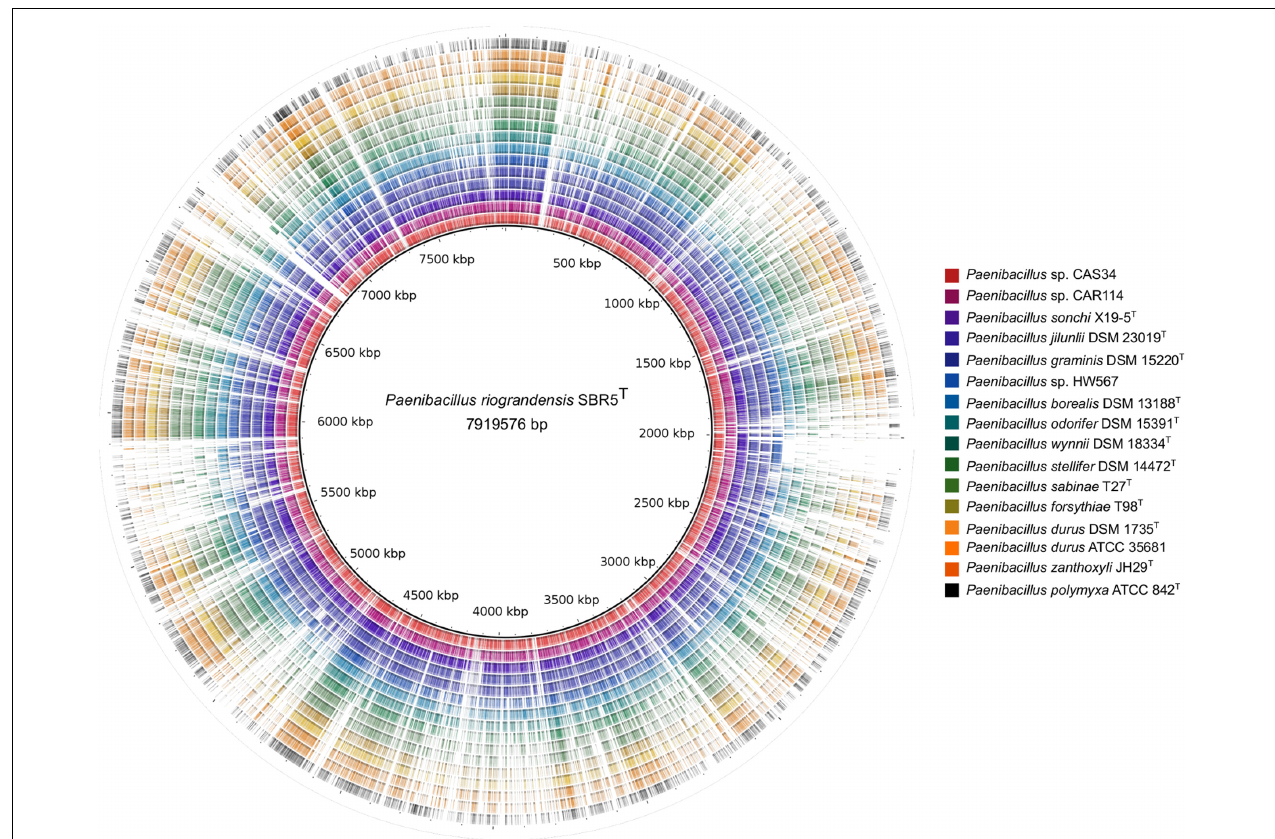
FIGURE 3 | Comparison of predicted proteins of Paenibacillus spp. against the P. riograndensis SBR5 translated genome sequence. The innermost black line circle represents the P. riograndensis SBR5 genome sequence. Each one of the outer rings represents a Paenibacillus strain, as depicted in the legend box. Colored regions of each ring symbolize tblastn hits with at least 30% of identity.